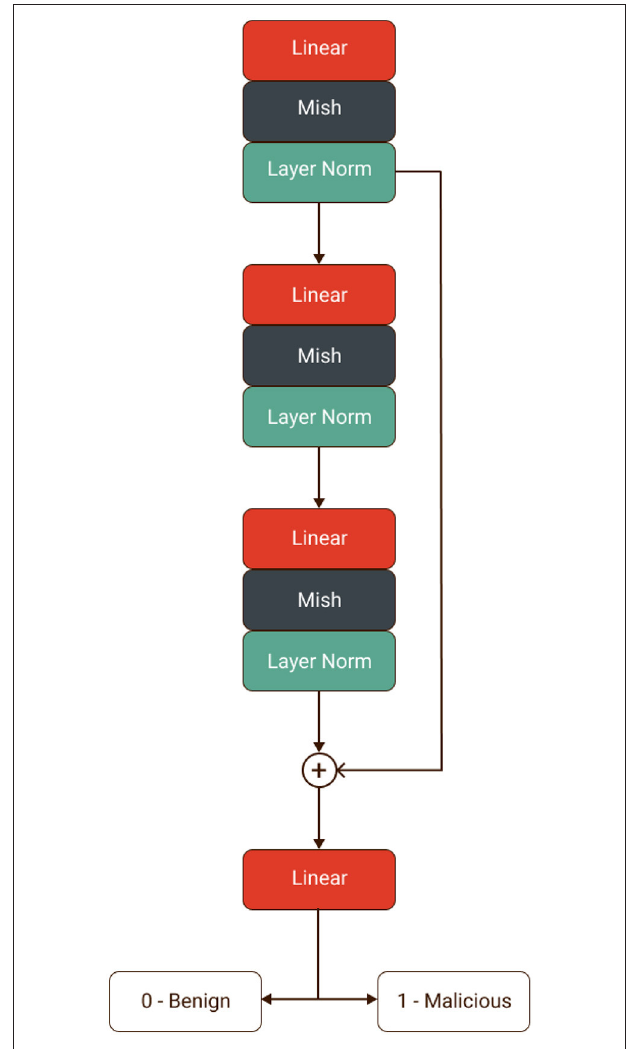
FIGURE 9 | ImmuneNet